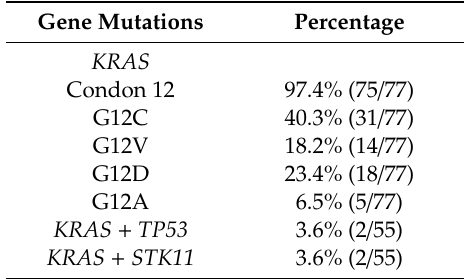
Table 4. KRAS mutation subtypes and